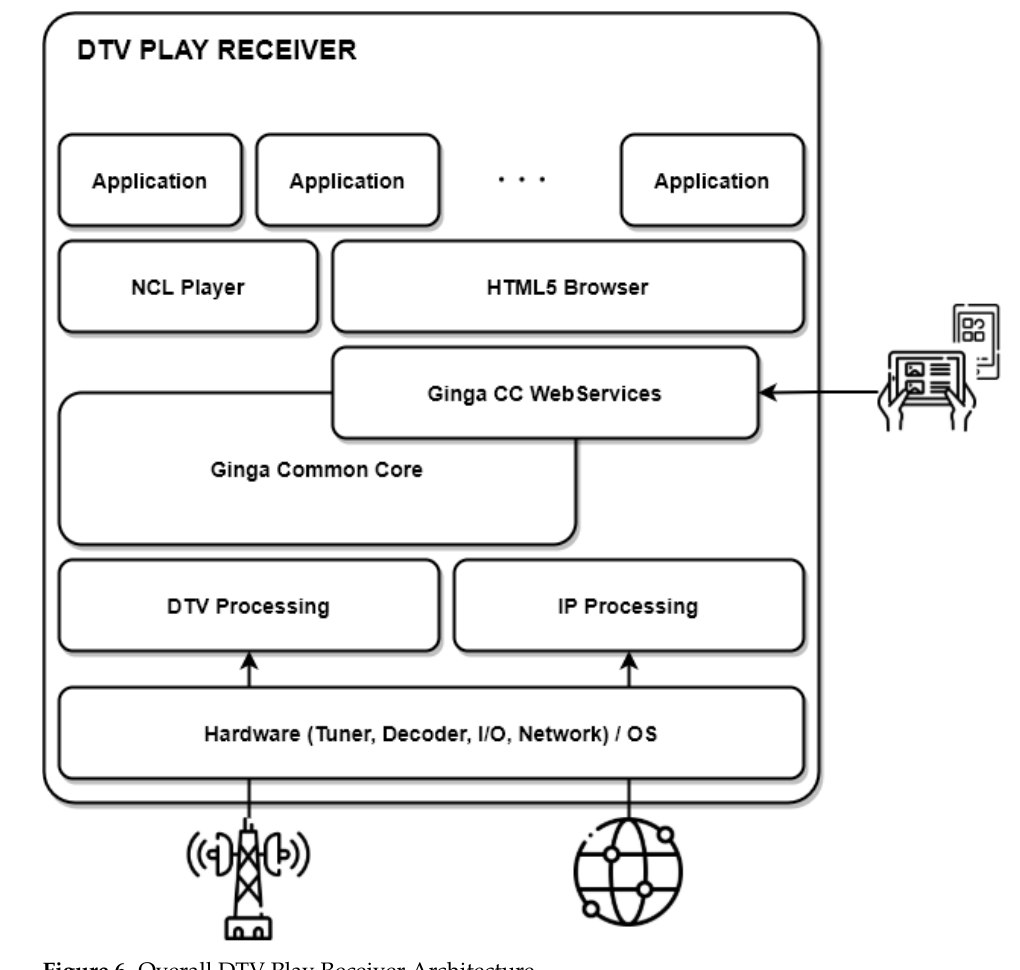
Figure 6. Overall DTV Play Receiver